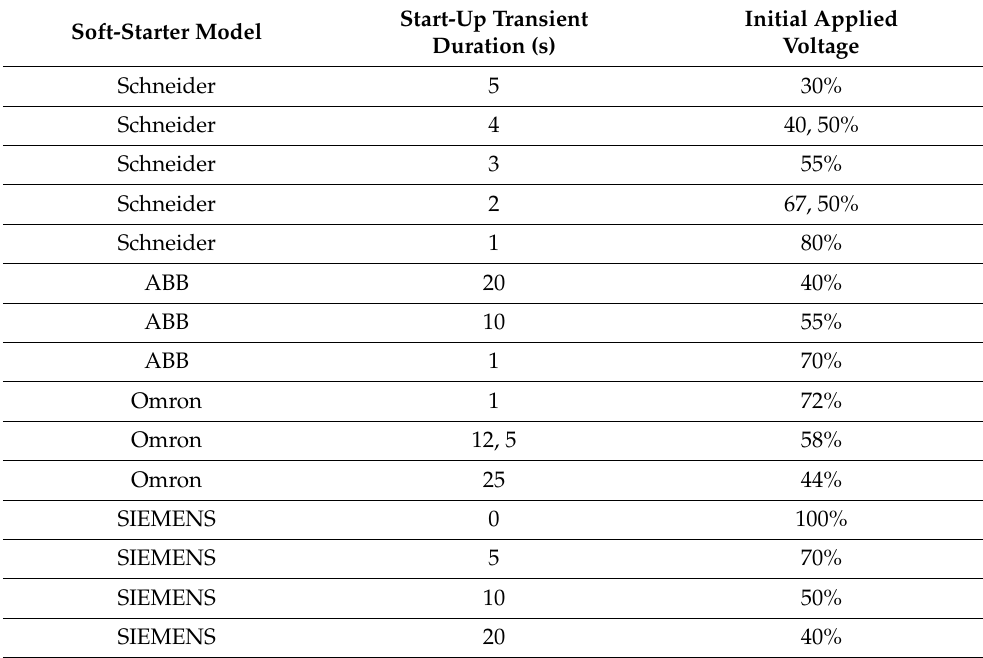
Table 2. Main characteristics of the industrial soft-starters used during experimentation.